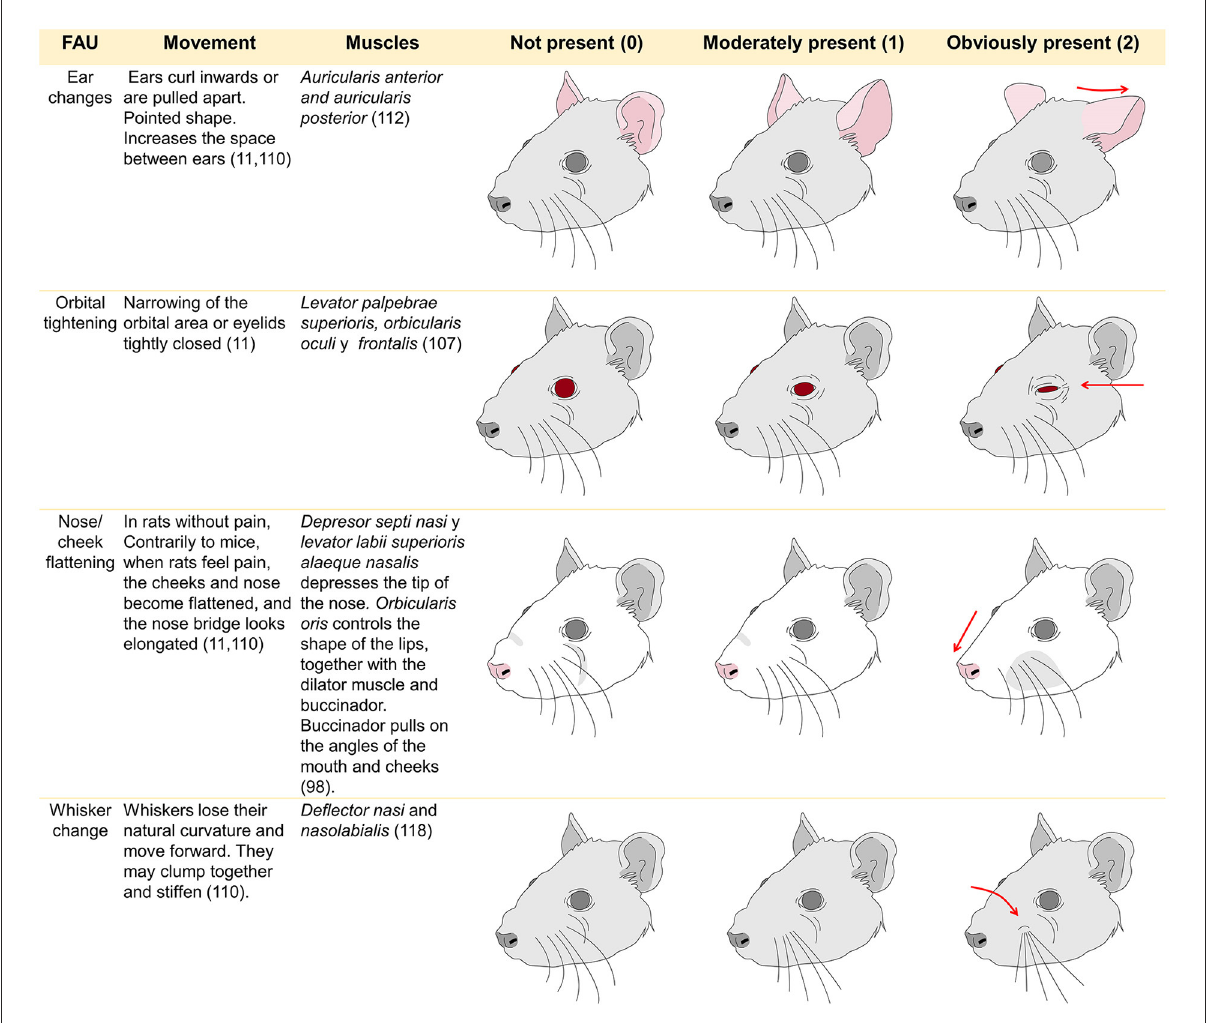
FIGURE4 Facial action units used to evaluate facial expression in rats and their muscles involved in its